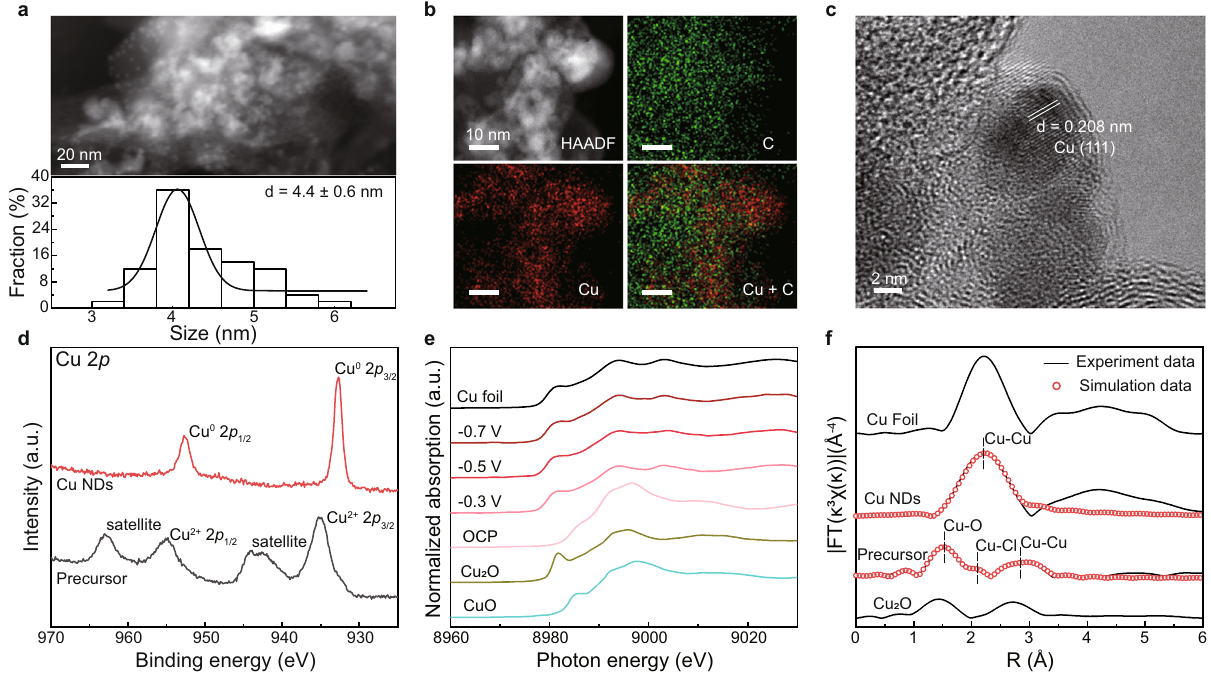
Fig.1|StructuralcharacterizationoftheCuNDscatalyst.a HAADF-STEMimage ofCuNDs(up)andthecorrespondingsizedistributionhistograms(down). b STEM- EDX mapping of the Cu NDs catalyst. c HRTEM image of the Cu NDs catalyst. d Cu 2 p XPS spectra of the precursor and Cu NDs catalyst. e Normalized in situ XANES spectra of the Cu NDs catalyst under EASH conditions at different working